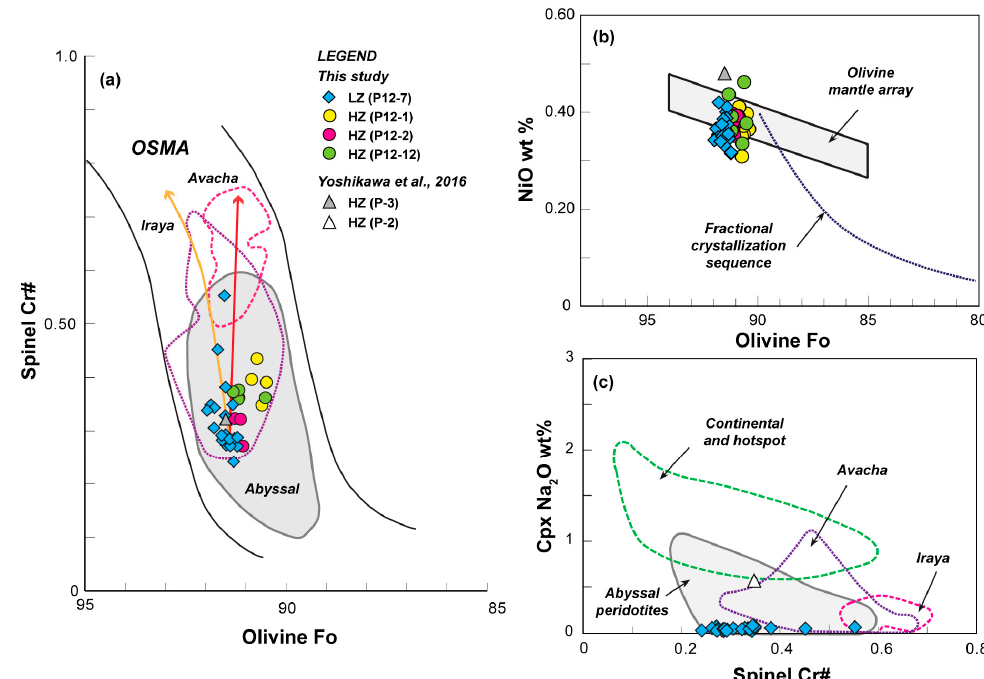
Figure 6. ( a ) Olivine forsterite vs spinel Cr#. The Mt. Pinatubo spinel peridotite xenoliths plot within the olivine spinel mantle array (OSMA) [8]. The spinel lherzolite (LZ) shows higher Fo content for a given Cr# compared to the spinel harzburgites (HZ). Abyssal peridotite [8], and Avacha and Iraya fields [21] are also shown. The orange arrow indicates the residual trend for spinel peridotites [8] while the red arrow defines the trend for the Avacha peridotite xenoliths [21]. ( b ) Olivine forsterite versus NiO wt%. The Mt. Pinatubo spinel lherzolite and harzburgite xenoliths plot within the olivine mantle array [45]. The fractional crystallization trend is after Sato [47]. ( c ) Spinel Cr# vs Cpx Na 2 O. The clinopyroxenes in the spinel lherzolite xenolith from Mt. Pinatubo show very low Na 2 O content. References for the different fields are as follows: abyssal, continental and hotspot [48], Avacha [21] and Iraya [4,18].